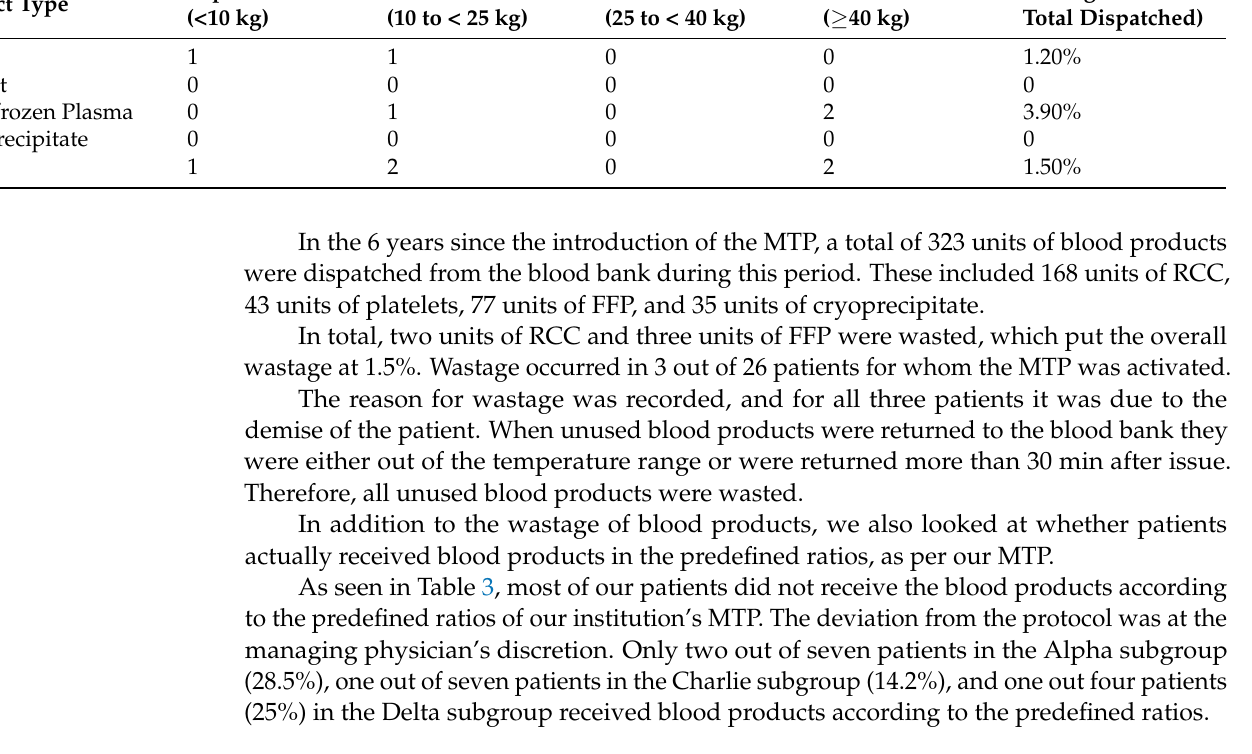
Table 3. Number of patients in each weight subgroup and number who received blood products in the predefined